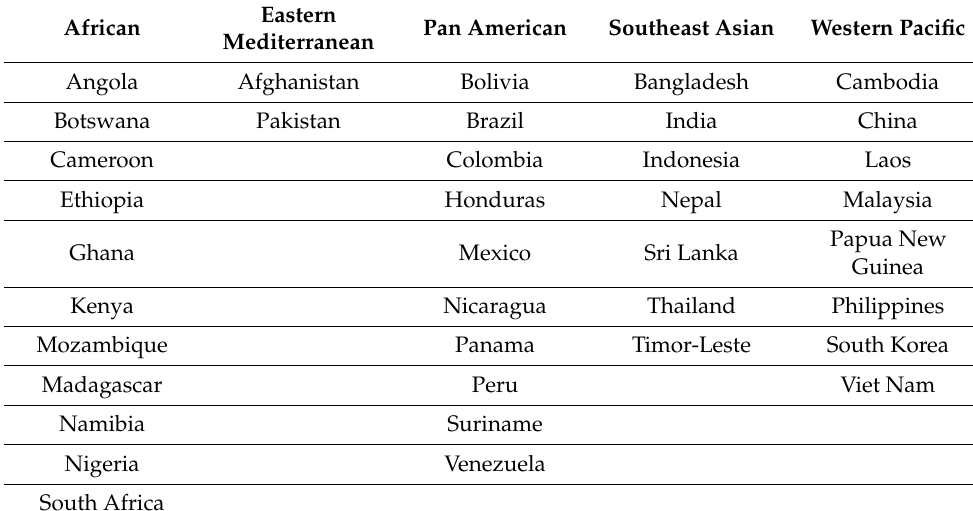
Table 1. Nations surveyed among five WHO regions.